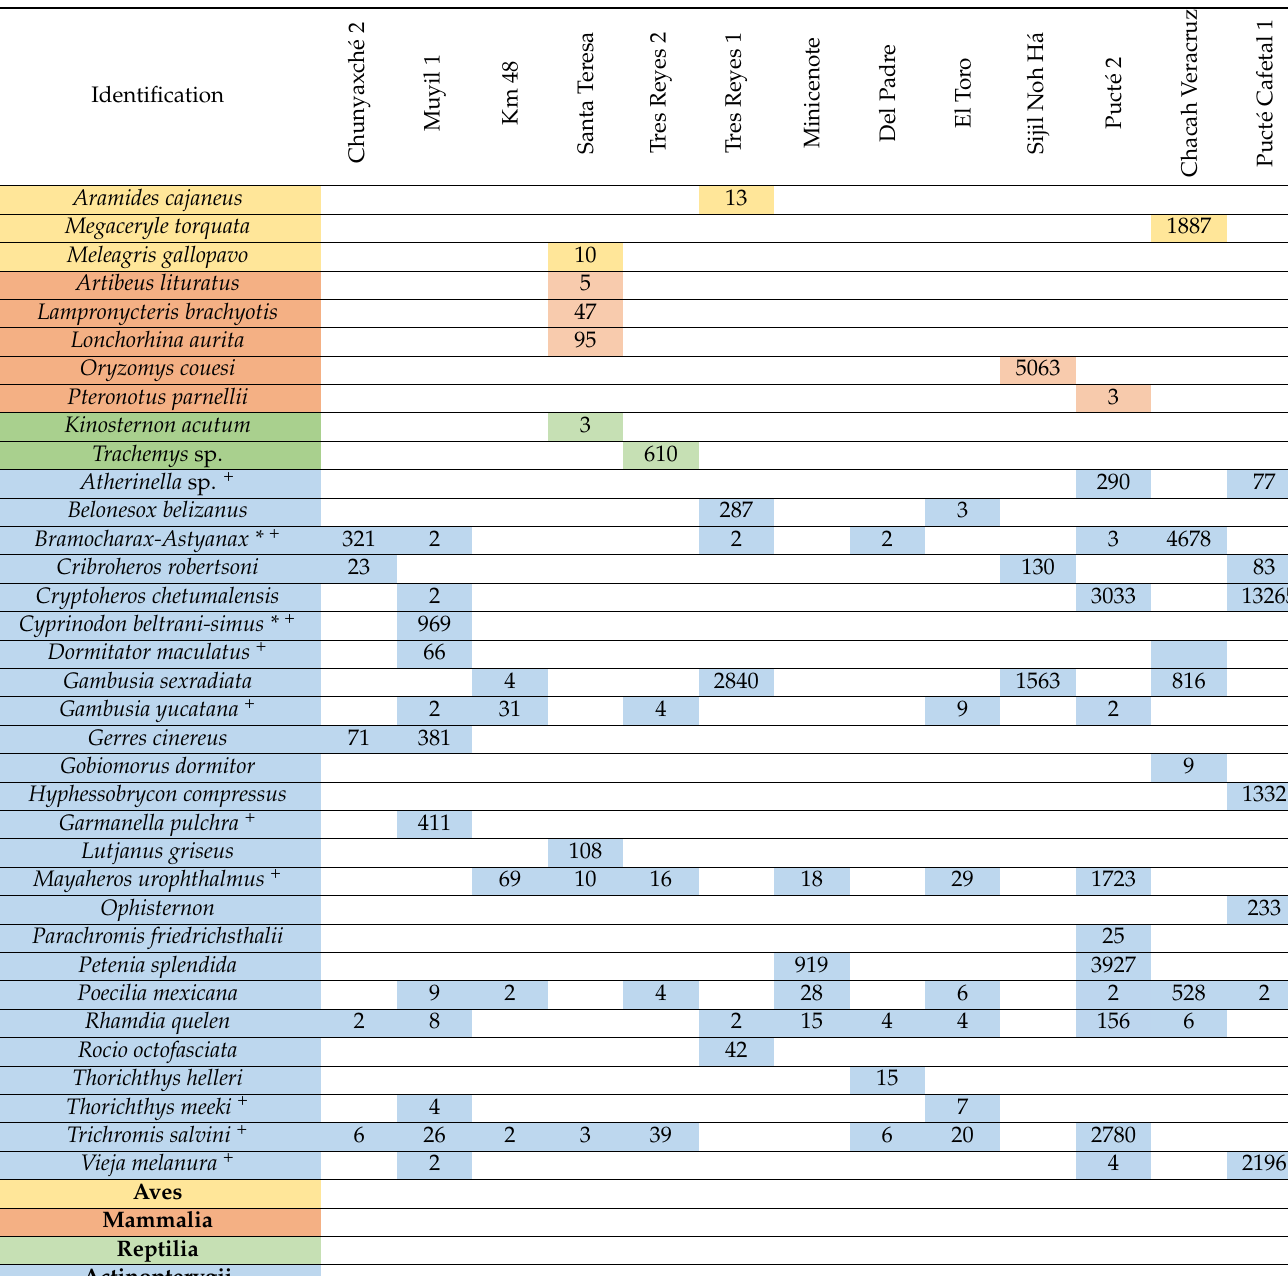
Table 3. Summary of identification results after metabarcoding, filtered by min score 250 and genus/species identity filter. Genera (species complexes) with low interspecific resolution are marked with *. Numbers correspond to sequences matched. Muyil 2 and Chunyaxch é 2 were not sampled for this analysis. + A possible new